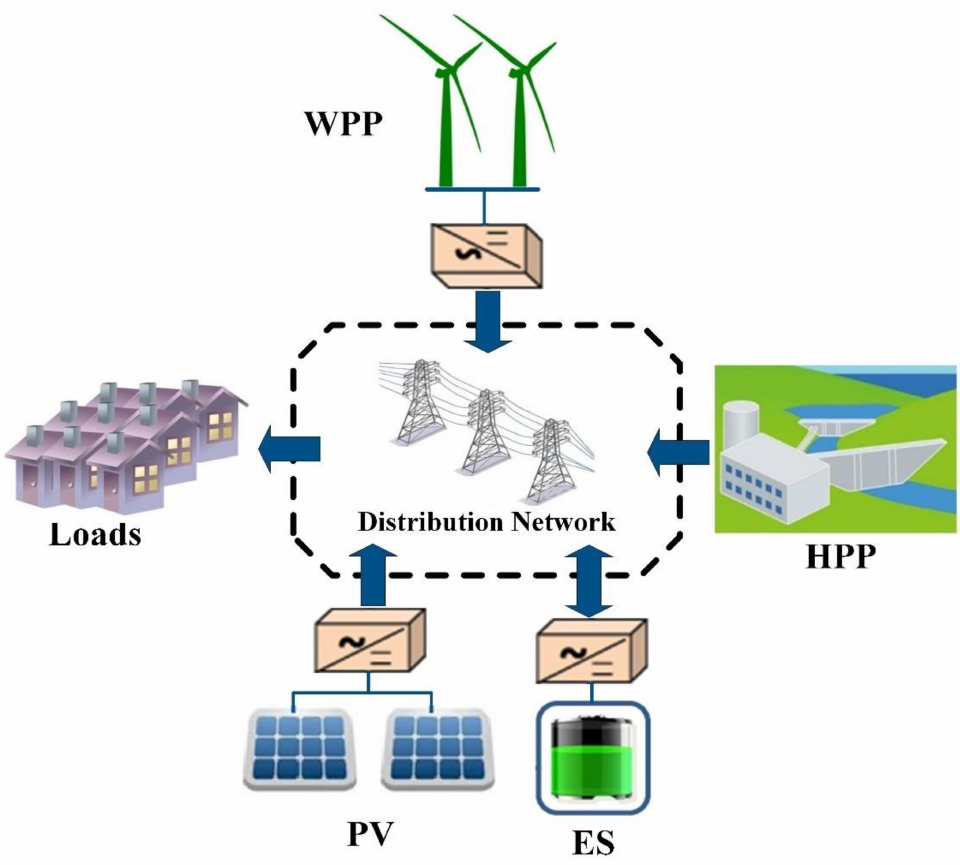
Figure 2. Overview of the proposed hybrid power